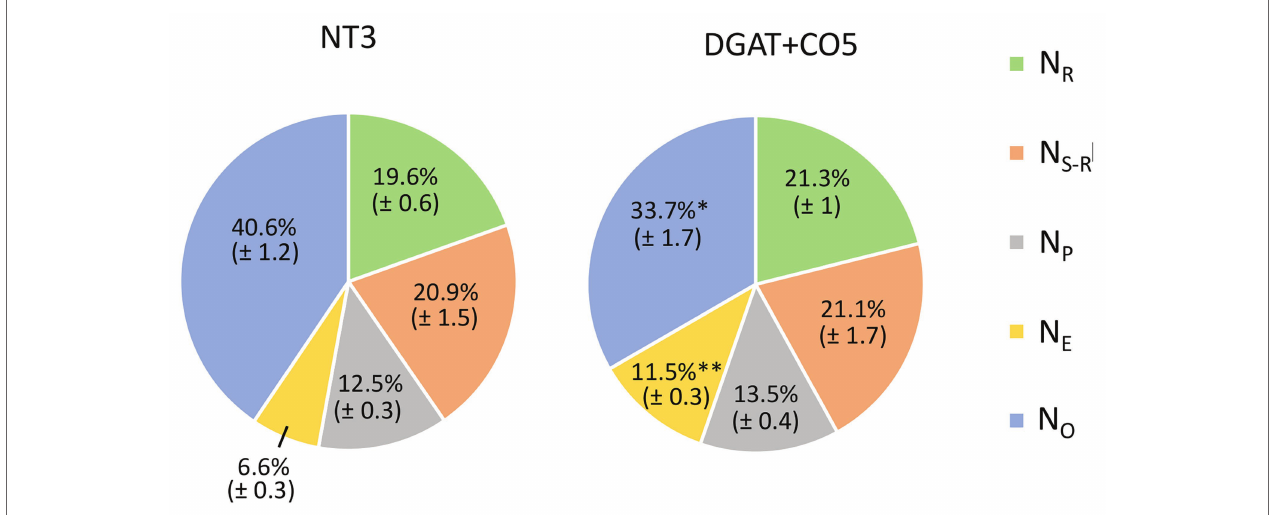
FIGURE 8 | Within-leaf N partitioning for L. perenne DGAT + CO5 and NT control NT3 grown under 5 mM NO 3− supply. N R (N invested in rubisco), N S-R (N invested in non-rubisco soluble protein), N